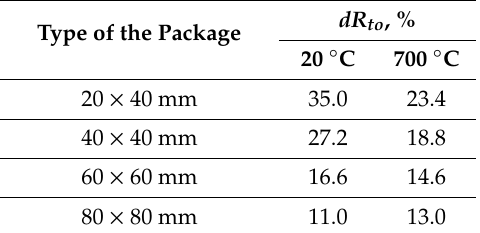
Figure 11. The values of the parameter dR to in the temperature function. Table 3. The values of the parameter dR to obtained for 20 and 700 ◦